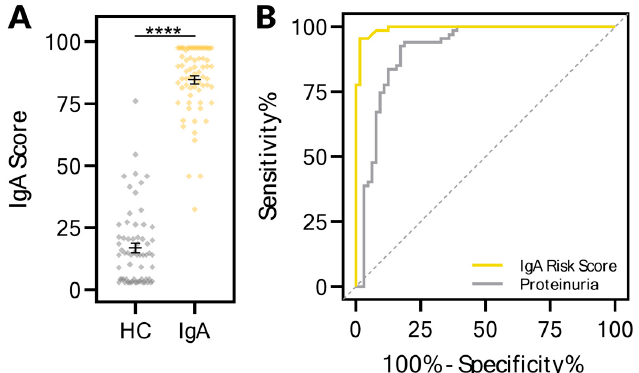
Figure 3. The urinary KIT biomarkers could segregate healthy controls from those with IgA nephropathy. ( A ) An IgA risk score ranging from 0 to 100 segregated healthy control patients from those with IgA nephropathy. Urine samples were collected from healthy controls ( n = 64) who had no evidence of kidney disease or injury as assessed by both absence of proteinuria and eGFR greater than 120. All urine samples from IgA patients ( n = 67) were used, as none of these patients had remission of IgA during the treatment duration. ( B ) Receiver–operator characteristic (ROC) curves of the IgA risk score with AUC of 0.994 ( p < 0.0001) and proteinuria. For the IgA risk score, the sensitivity and specificity were 95.5% and 98.4% respectively. **** p <